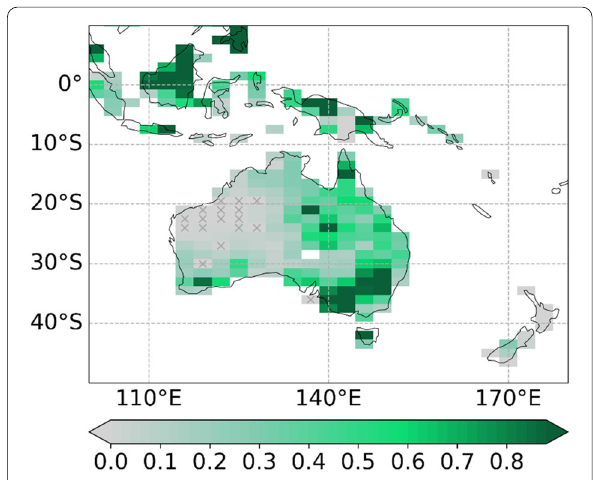
Fig. 1 Observed change in LAI. The spatial pattern of greening is calculated as the difference between the mean LAI in the periods 2007–2011 and 1982–1986. The greening pattern is interpolated to be consistent with the resolution of the model input. The cross symbols show pixels where LAI changes are small (< 10th